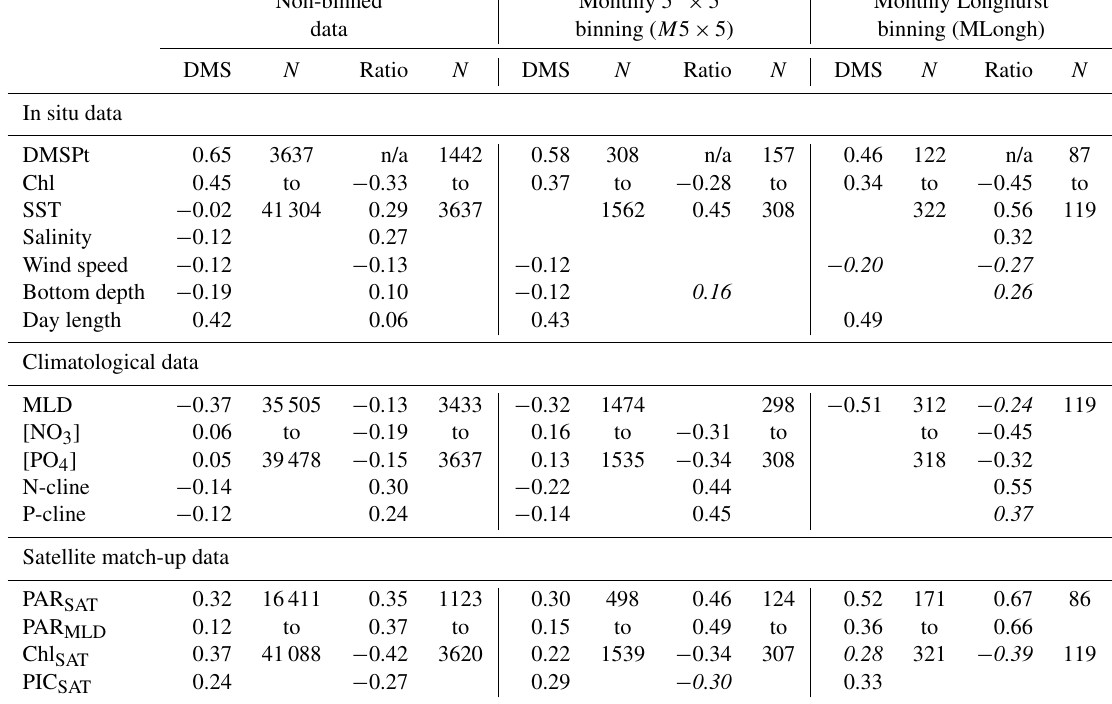
Table 1. Correlation analysis (Pearson’s r ) for different data binning levels. Pearson’s r with p value < 0 . 01 are not shown; values in italic are 0 . 0001 < p < 0 . 01; n/a: not applicable. “Ratio” refers to log 10 (DMS / DMSPt). DMS, DMSPt, Chl, MLD, [NO 3 ] and [PO 4 ] were log 10 transformed; Pearson’s r calculated on log 10 -transformed variables were higher than those calculated on the same non-transformed variables, and similar in magnitude to Spearman’s rank correlations. Bottom and nutricline depth values are shown as positive values (deeper is bigger). See the text for other